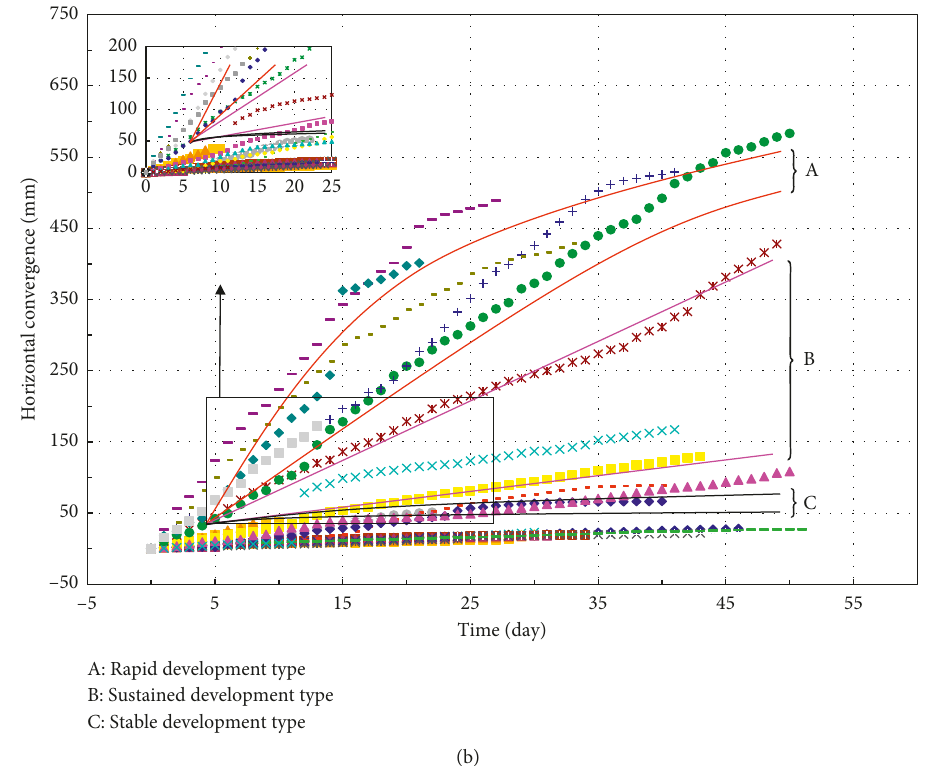
Figure 13: Deformation curve of surrounding rocks in the Qinggangshan tunnel exit: (a) settlement of vault crown; (b) horizontal convergence.